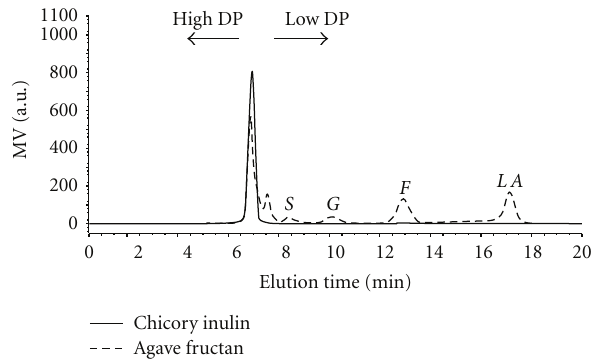
Figure 2: HPLC separation of sugars from agave fructan and chicory inulin used as substrates. S : sucrose, G : glucose, F : fructose, LA : lactic